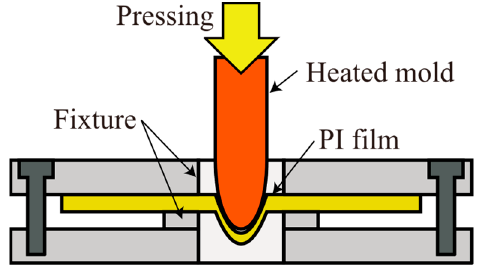
Figure 8. Outline of molding process.